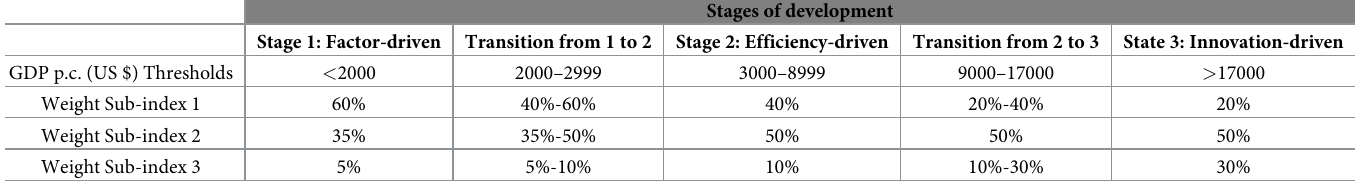
Table 1. Sub-index weights considering the stage of development.